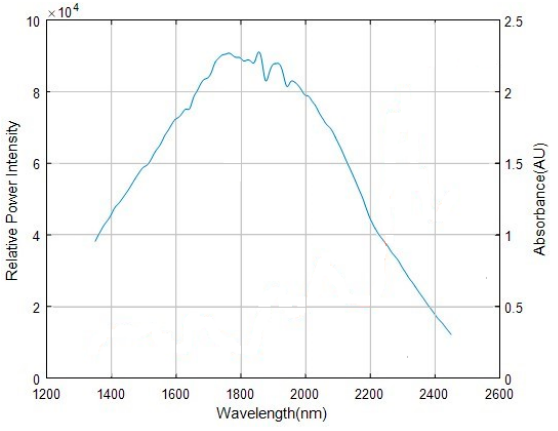
Figure 2. Light source spectrum.